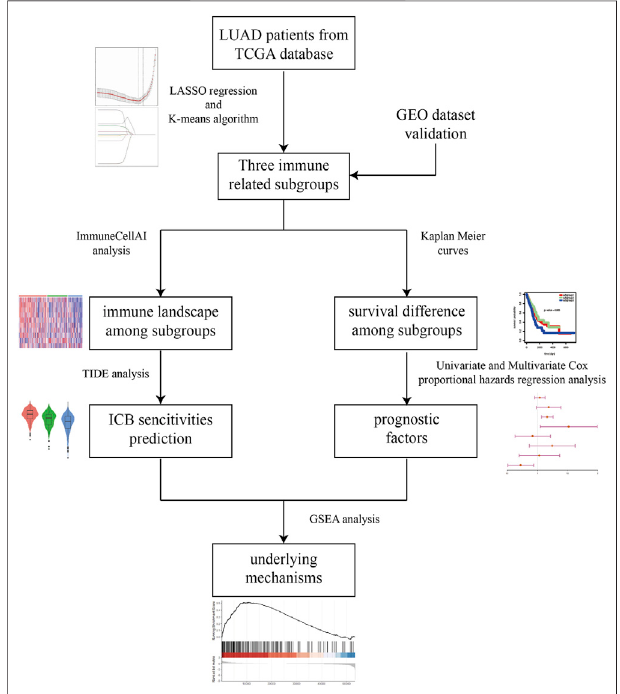
FIGURE1| Thework fl owofthisstudy.Brie fl y,immunerelatedsubgroup clustering was performed by using LASSO algorithm and K-means algorithm. After characterization of the immune associated signatures of the identi fi ed subgroups, TIDE algorithm analysis was performed to predict the potential sensitivities to ICB therapy. Meanwhile, survival analysis and further Cox proportional hazards regression analysis were also performed for LUAD. In the end, GSEA was performed to explore the metabolic mechanism potentially responsible for immune related subgroup